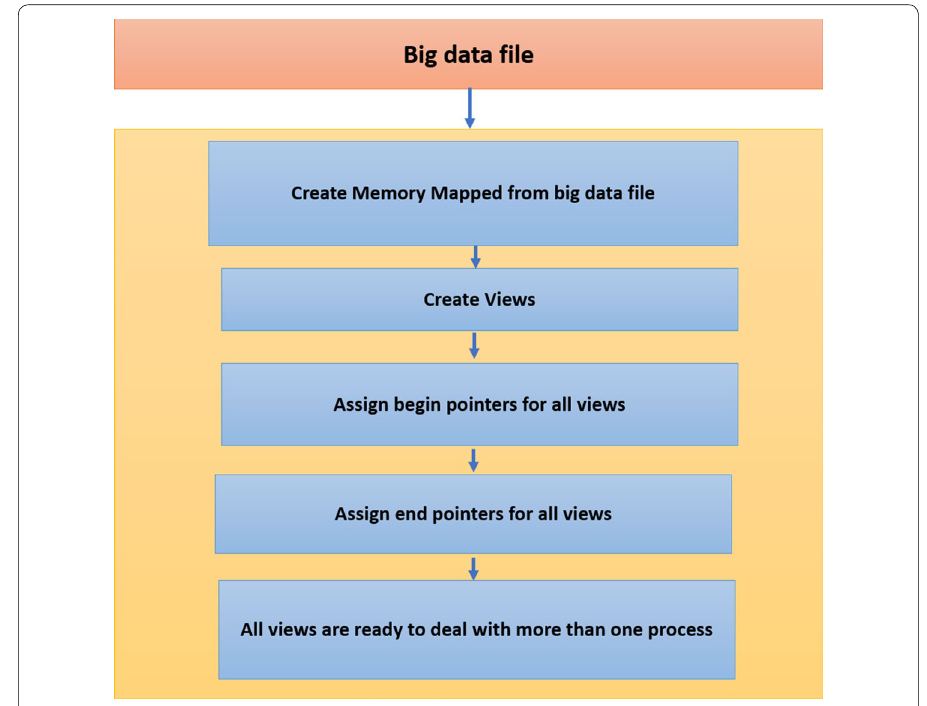
Fig. 5 Diagram of the creation of memory mapped